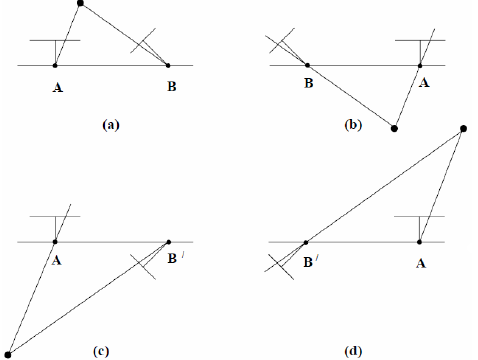
Figure 1. The four possible solutions for calibrated reconstruction from E.